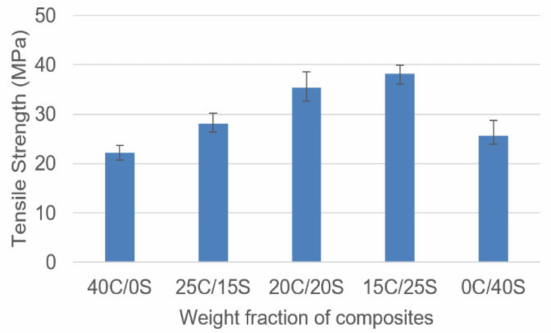
Figure 5. Tensile strength vs. weight fraction of C/S composites.